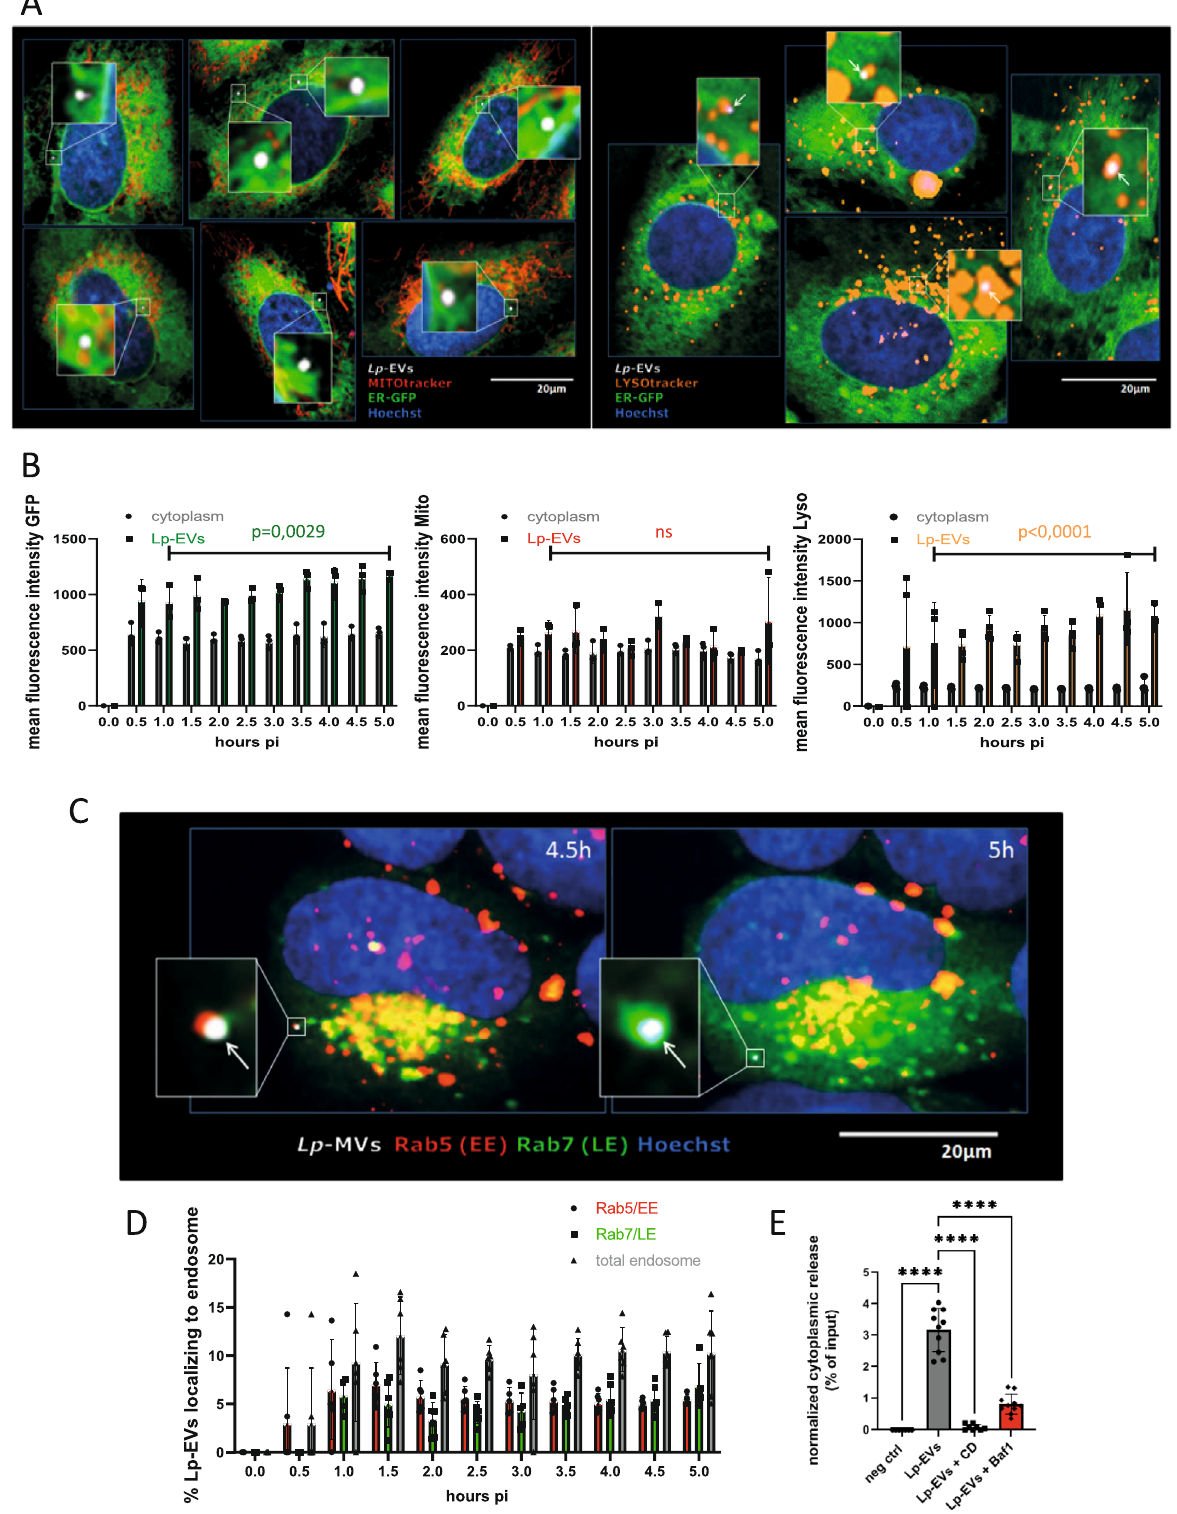
but not with mitochondria (Fig. 3A). To quantify the events, we applied High-Content Analyses (HCA) of single cells. The DiD signal was used to detect Lp -EVs in the cytoplasm of U2OS- Sec61 β -GFP cells and the fl uorescence of Mitotracker, Lyso- tracker, Sec61 β -GFP were measured to analyze in hundreds of living cells at the single cell level if Lp -EVs co-localize